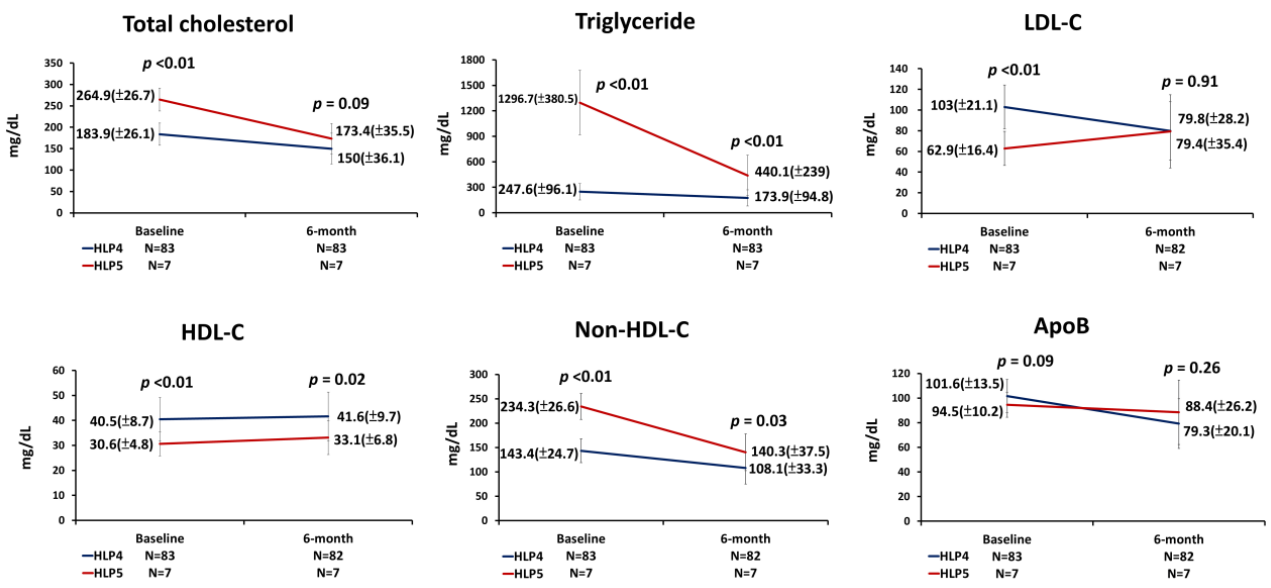
Figure 2. The changes of lipid parameters from baseline to the 6-month follow-up in patients with HLP4 and patients with HLP5. ApoB = apolipoprotein B; HDL-C = high-density lipoprotein cholesterol; HLP4 = type IV hyperlipoproteinemia; HLP5 = type V hyperlipoproteinemia; LDL-C = low density lipoprotein cholesterol; N = number; Non-HDL-C = non-high-density lipopro- tein cholesterol (p value was calculated as HLP5 vs.